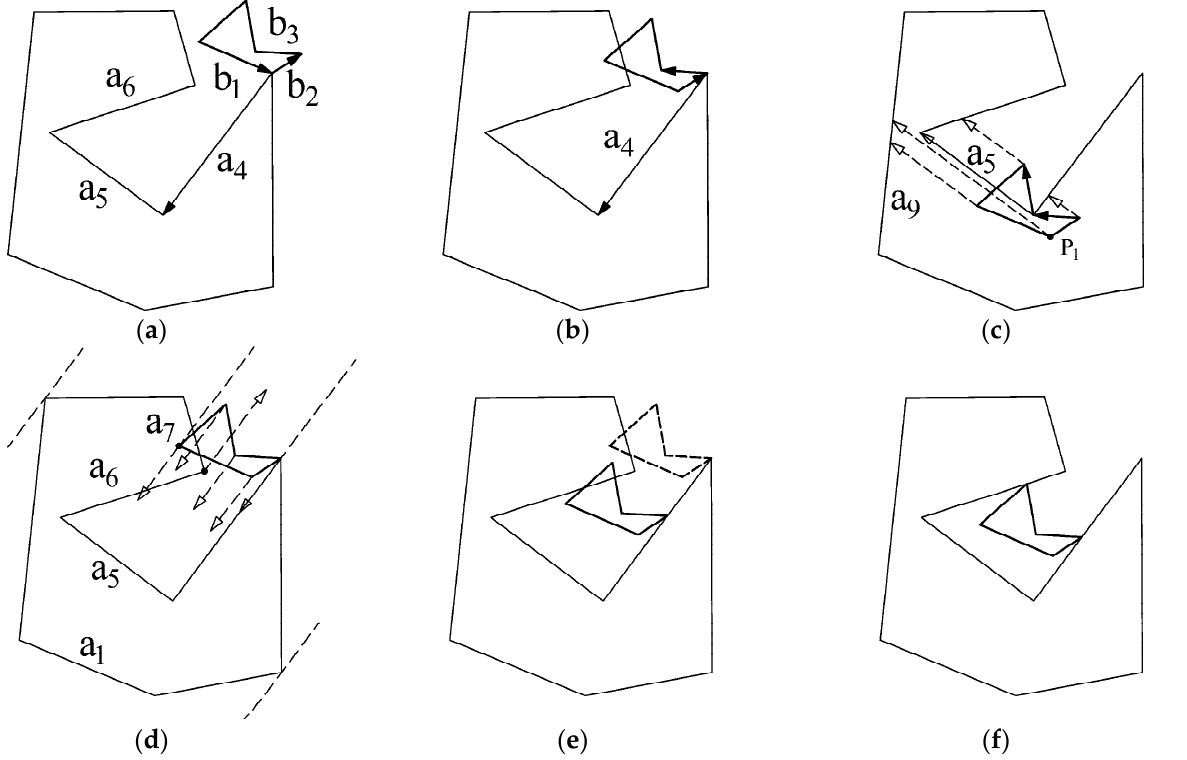
Figure 12. Improvements on searching start position and the generation process. ( a ) Failure to right side test; ( b ) Right sided test is passed; ( c ) Illustration of point inclusion strategy; ( d ) Illustration of point exclusion strategy; ( e ) Translation along edge a 4 ; ( f ) The feasible start position.